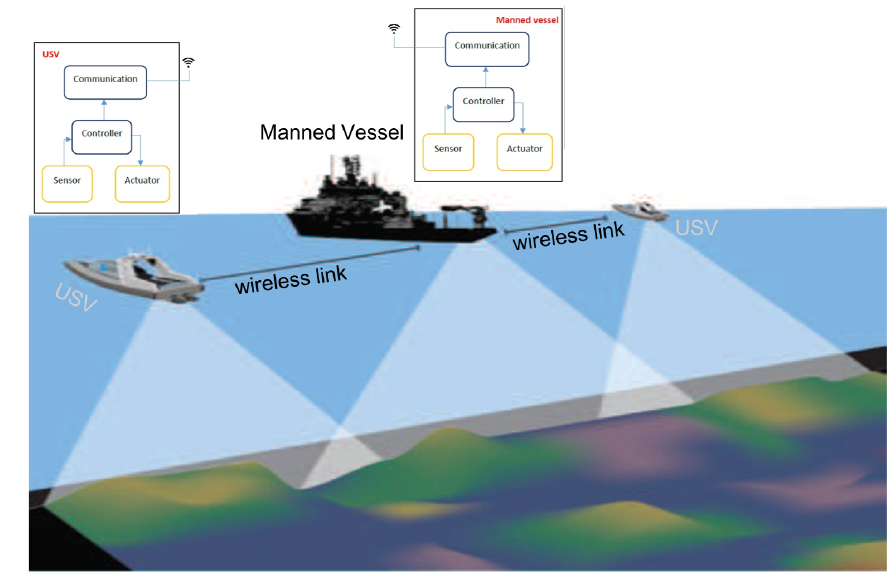
Figure 2. During the bathymetry measurements operation, the boats and the unmanned surface vehicle (USV) communicate wirelessly for